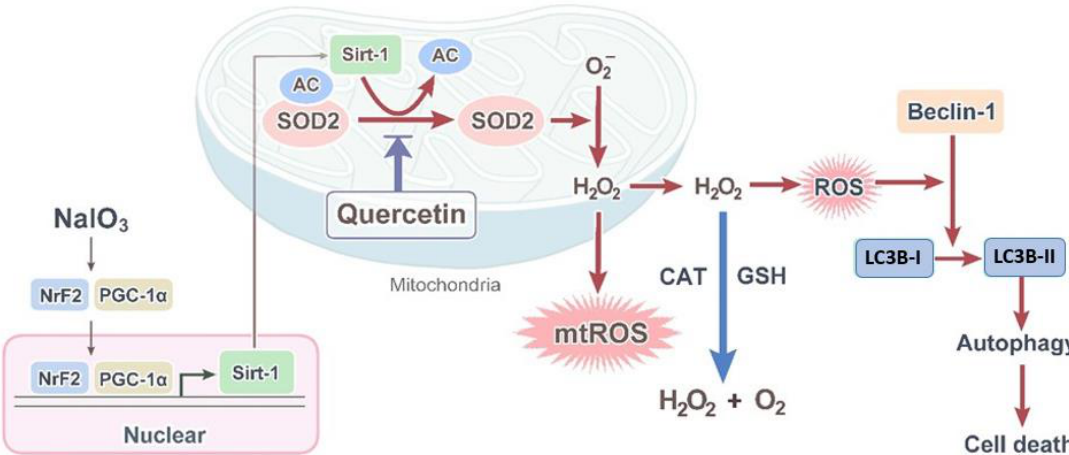
Figure 8. Proposed mechanism for the regulation of mtROS homeostasis by quercetin through the Sirt1 signaling pathway in NaIO 3 -induced retinal damage. Quercetin triggers the Nrf2-PGC-1 α -Sirt-1 signaling pathway, which is required for Nrf2-PGC-1 α -dependent Sirt1 transcription and subsequent enrichment within the mitochondria, thereby leading to deacetylation and activation of mitochondrial enzymes (SOD2) involved in mtROS regulation as well as stimulating mitochondrial H 2 O 2 synthesis, finally contributing to mtROS homeostasis in the retina, and then alleviating NaIO 3 -induced autophagic cell death, including the upregulation of LC3B, Beclin-1, and p62, as well as downregulation of Bcl-2. Quercetin treatment decreased the levels of related factors, which controlled the quality of mitochondria. Ac: acetyl.